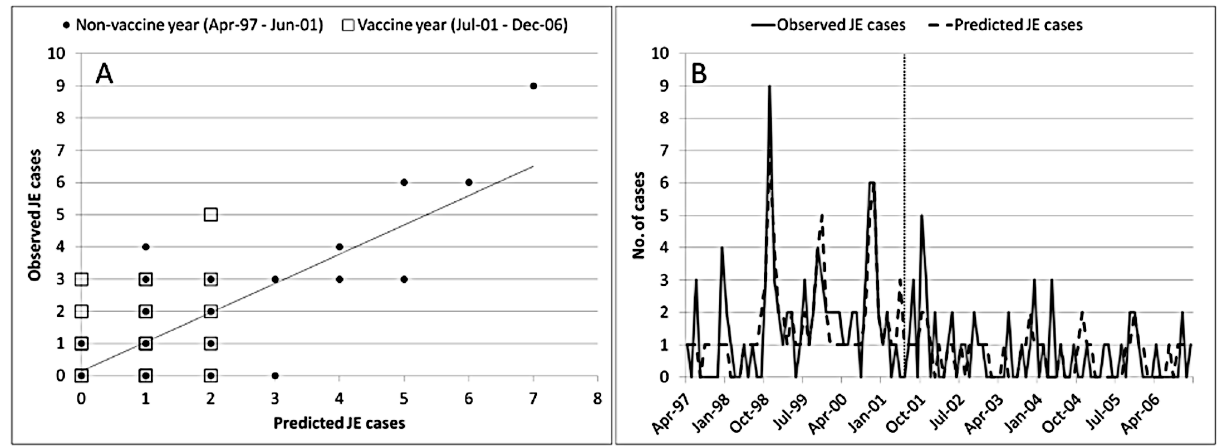
Figure 2. Observed versus predicted JE cases for observed climate and vaccine model (vaccine, seasonality, temperature, rainfall and SOI): time series (A); the vertical grey dotted line represents the introduction of the JE vaccine into the National Immunization program in Sarawak, Malaysia in July 2001 and scatter plot (B) of predicted versus observed values of JE cases; diagonal line represent the trend through all data points during the non-vaccine and vaccine years. Model fitted using Poisson regression.